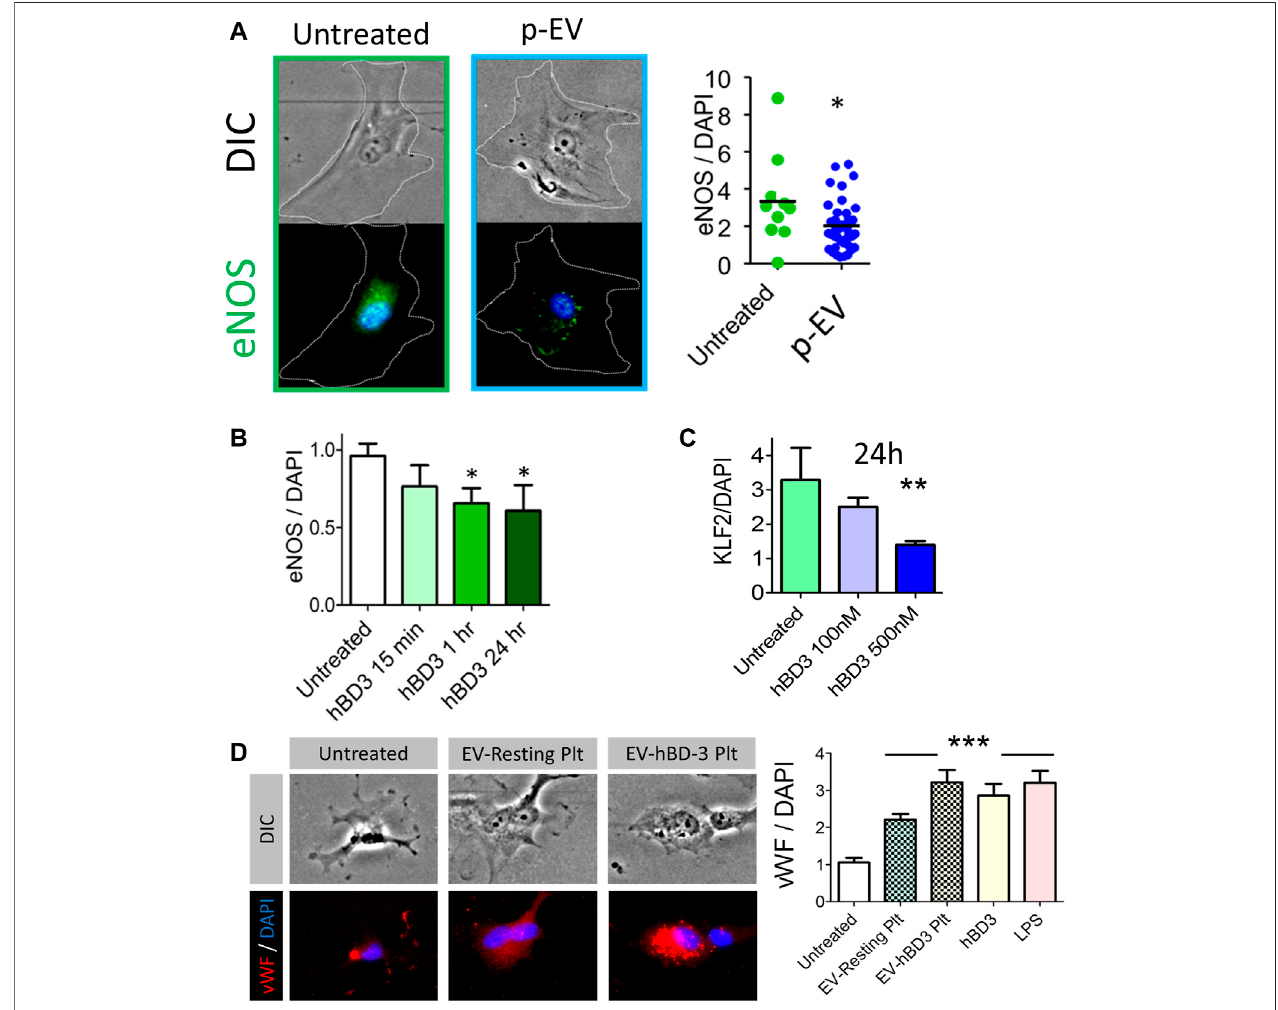
FIGURE 4 | Exogenous hBD-3, p-EVs, and p-EVs from hBD-3 pre-exposed platelets induce endothelial dysfunction. (A) Left and middle panels: Representative fl uorescentandDICimagesofHAoECshowingendothelialnitricoxidesynthase(eNOS)expression(green;leftandmiddlepanel),inendothelialcellsafter24 hchallenge without or with p-EVs and nuclei (DAPI, blue). Right panel: quantitative mean fl uorescence intensity (MFI) ratio from the respective experiments ( n = 8, * p < 0.05); (B) Expression of endothelial eNOS after various time points of hBD-3 (100 nM) exposure. (C) Nuclear Krüppel-like factor 2 (KLF-2), expression in primary endothelial cells following 24 h exposure to ascending concentrations of hBD-3. ( n = 3, * p < 0.05); (D) Left panels are representative fl uorescent and DIC images showing von Willebrand Factor (vWF) (red) expression in untreated HAoEC or following treatment with EVs from resting platelets (EV-resting Plt) and EVs from hBD-3 exposed (24 h) platelets (EV-hBD-3 Plt). Right panel: MFI ratio indicating vWF levels in HAoEC treated with EVs from untreated, resting and hBD-3 exposed platelets (EV-hBD-3-Plt). Synthetic hBD-3 (100 nM) and LPS (100 ng/ml) was used as a positive controls. Digital immuno fl uorescence image data was analyzed using 2-tailed Mann – Whitney tests; *** p <